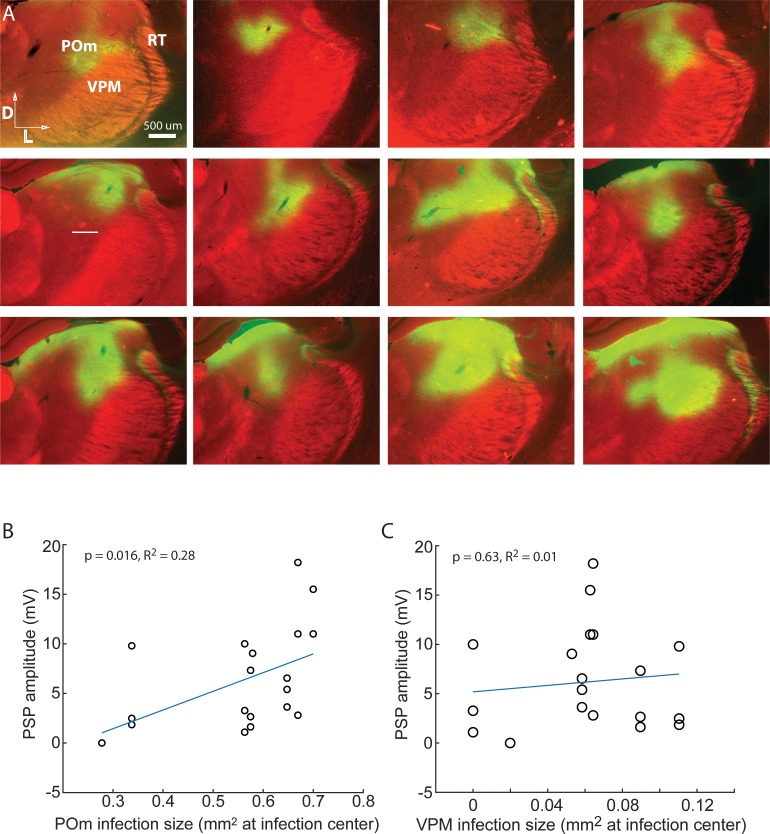
Strength of ChR-mediated input to L2/3 is related to POm not VPM infection.(A) Gallery of example POm infections. Green, immuno-amplified ChR2- YFP expression. Red, streptavidin-Alexa594. (B) Strength of ChR-mediated input to L2/3 is related to POm infection size (linear regression, p = 0.016). POm infection size accounts for 28% of the variability in PSP amplitude (R2 = 0.28). (C) Strength of ChR-mediated input to L2/3 is unrelated to VPM infection size (p = 0.63), which accounts for virtually no variability in PSP amplitude (R2 = 0.01).